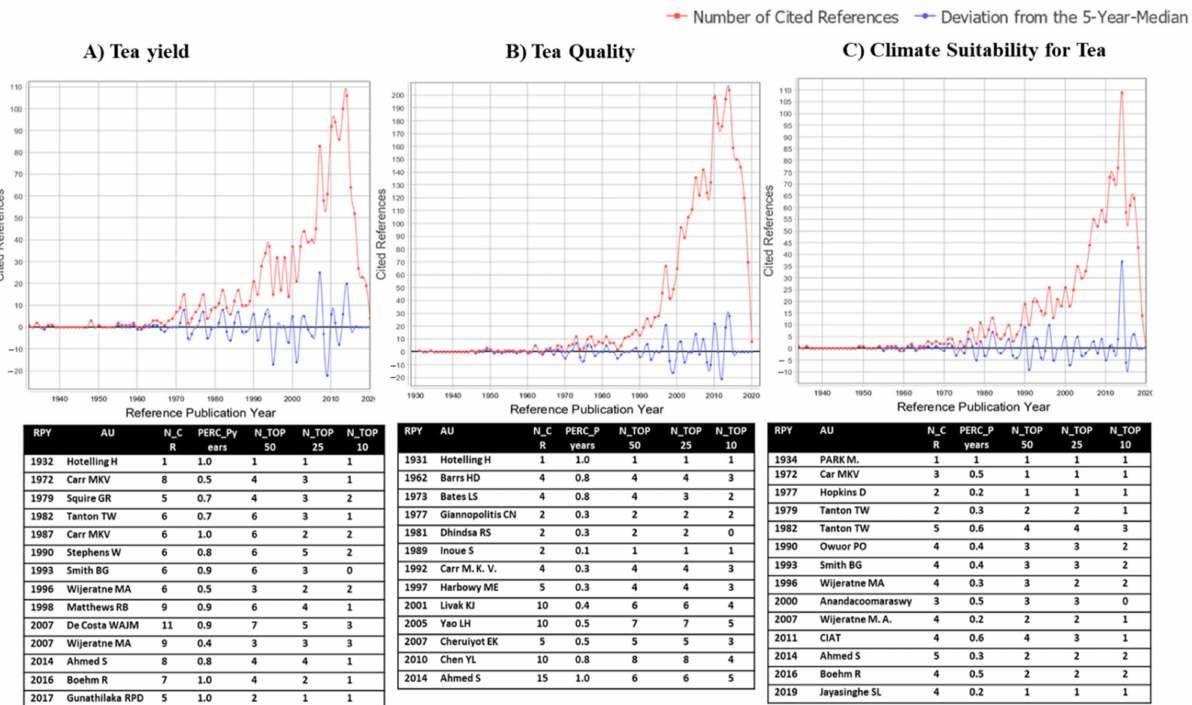
Figure 2. The Reference Publication Year Spectroscopy (RPYS) spectrograms and the distribution by reference publication year for 1930–2020 of the main references cited, based on the subjects’ entitled effect of climate change on the ( A ) yield ( B ) quality and ( C ) climate suitability for tea, with the historical roots of the relevant topics. Note: Highly cited papers included in the spectrogram, RPY: Reference publication year, N_CR: Number of cited references, PERC_Pyear: Percent in year, N_top 50: Top 50% cited reference, N_TOP 25: Top 25% cited reference, N_TOP 10: Top 10% cited